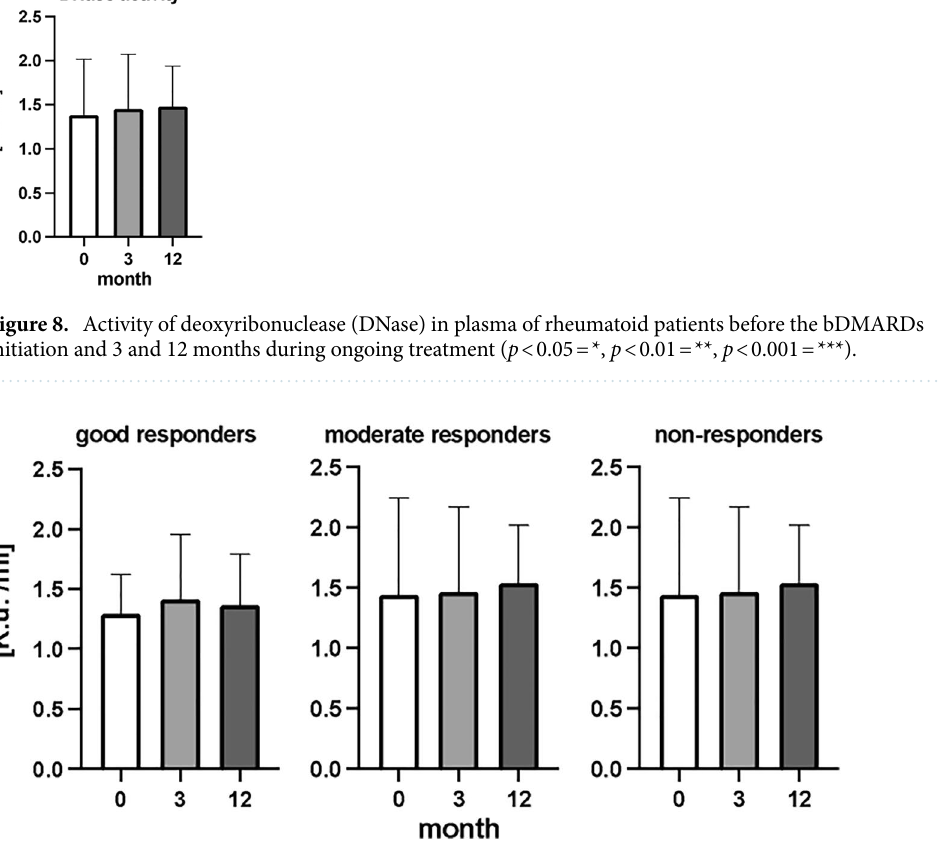
Figure 9. Activity of deoxyribonuclease (DNase) in plasma of patients with rheumatoid arthritis divided into groups based on their response to biological treatment (good, moderate, and non-responders). Before the bDMARDs initiation and 3 and 12 months during ongoing treatment ( p < 0,05 = *, p < 0,01 = **, p < 0,001 = ***).